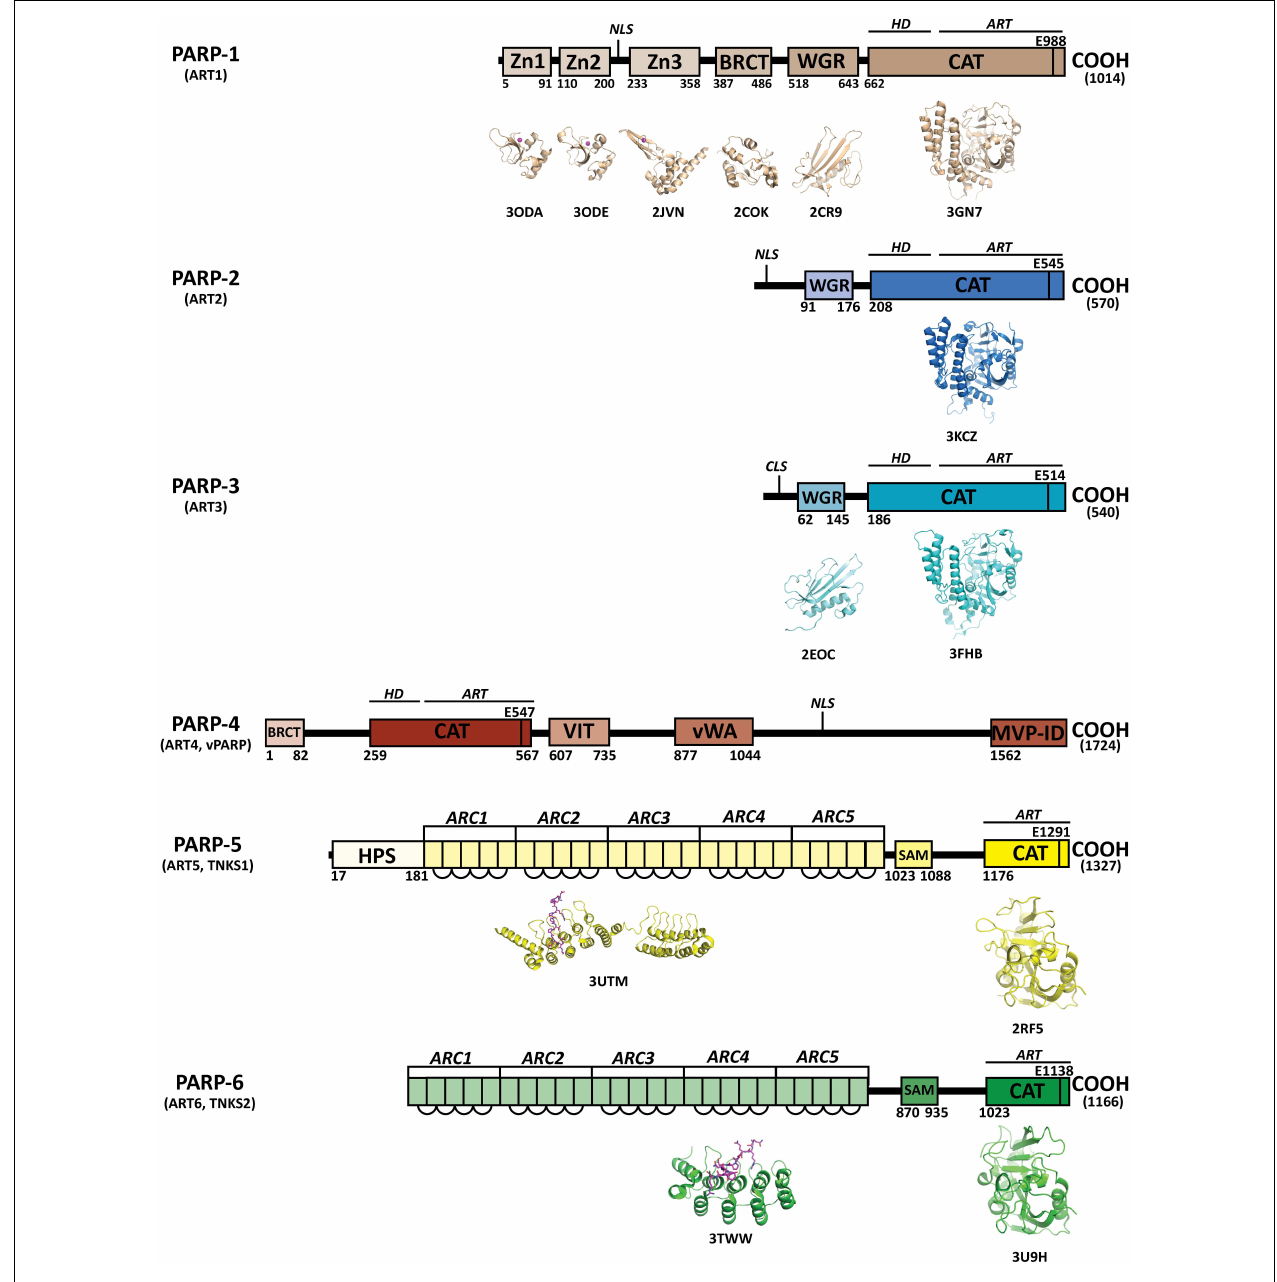
automodification domain of PARP-1, and is also present in PARP-4. Zinc-fingers Zn1 and Zn2 of PARP-1 are important in binding DNA, while the third zinc-finger (Zn3) is important in DNA-dependent catalytic activation. Other domains and sequences represented include: centriole-localization signal (CLS), vault protein inter-alpha-trypsin (VIT), vonWillebrand type A (vWA), major vault particle interaction domain (MVP-ID), His-Pro-Ser region (HPS), ankyrin repeat clusters (ARCs), sterile alpha motif (SAM), and nuclear localization signal